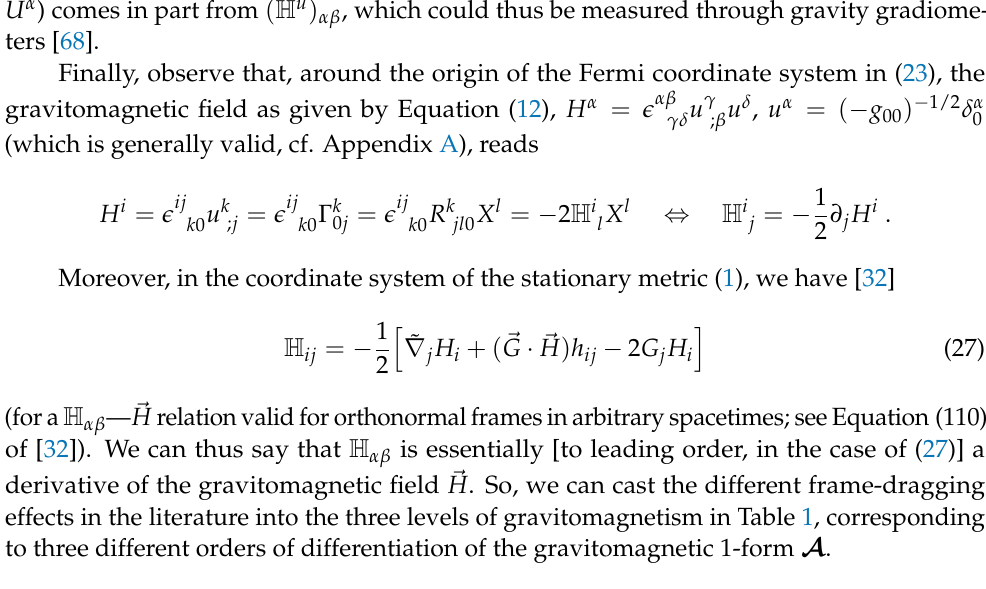
Table 1. The different effects under the denomination “frame-dragging”, cast into three levels of gravitomagnetism, corresponding to different orders of differentiation of the gravitomagnetic vector potential (cid:126) A